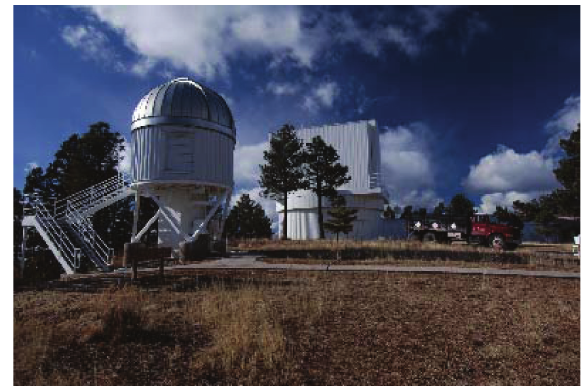
Figure 1: The NMSU 1m dome at Apache Point Observatory in New Mexico. The larger enclosure in the background is the ARC 3.5m telescope.